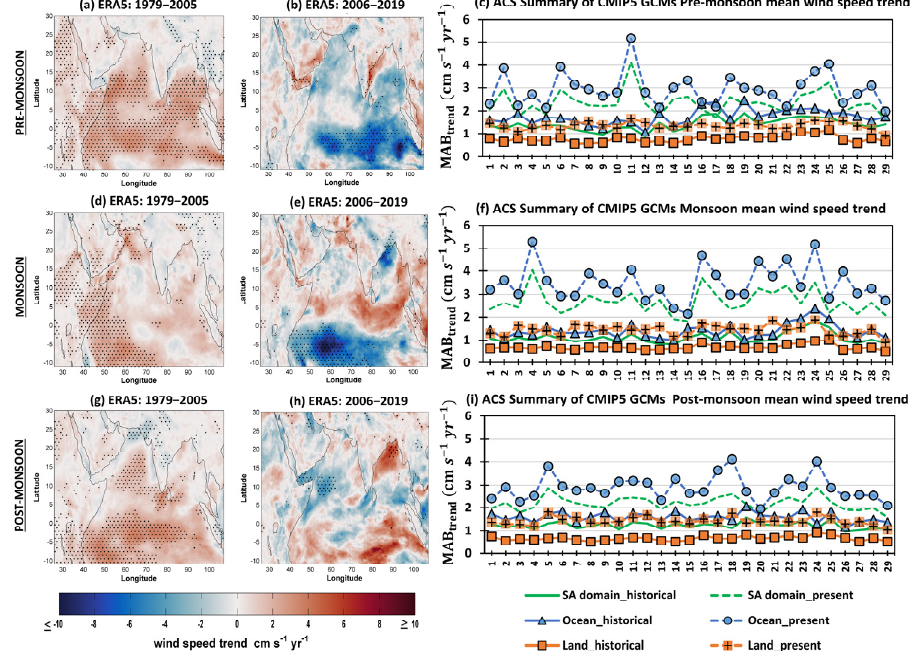
Figure 6. Pre ‐ monsoon (February − –May) mean wind speed trend spatial maps of ERA5 for the ( a ) Figure 6. Pre-monsoon (February–May) mean wind speed trend spatial maps of ERA5 for historical (1979 − 2005) and ( b ) present time slice (2006 − 2019). ( c ) As in Figure 2, but summarizes the climate model’s skill in simulating pre ‐ monsoon mean wind speed trend; mean absolute bias (MAB, cm/s/yr) on y ‐ axis and Model ID on x ‐ axis. ( d − f ) As in ( a − c ), but for monsoon season (June − Septem ‐